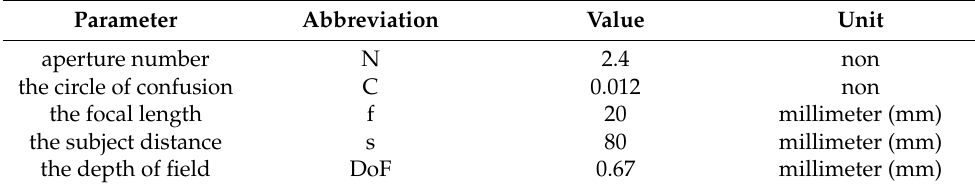
Table 2. The parameter of the depth of field ( DoF ) in the optical